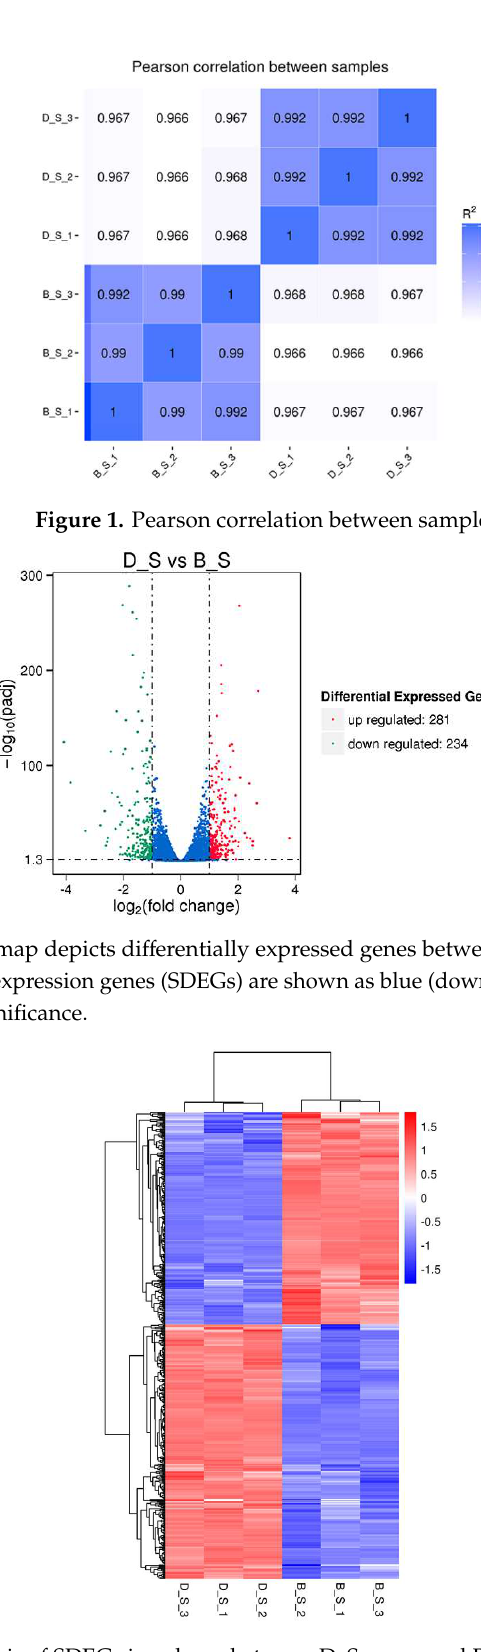
Figure 3. Cluster analysis of SDEGs in spleens between D_S group and B_S group by the FPKM value. High expression genes are shown in red and low expression genes are shown in green. The closer the branches of the two samples are, the closer the expression patterns of all genes in the two samples are, and the closer the trend of gene expression